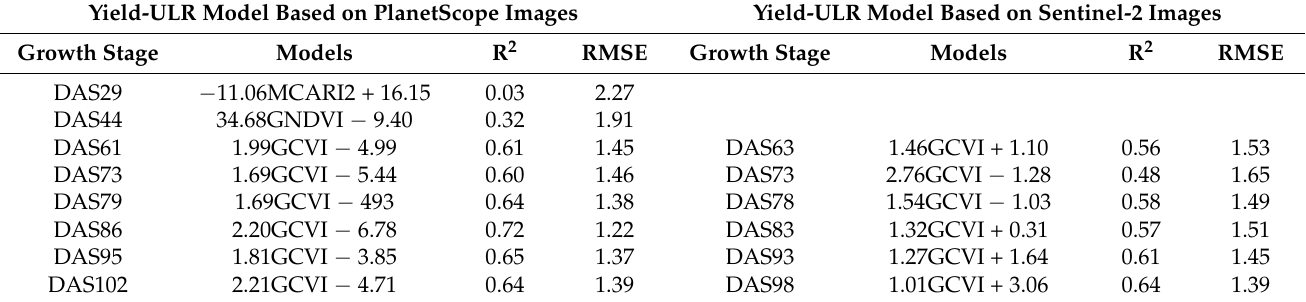
Table 3. The best Yield-ULR models constructed with PlanetScope and Sentinel-2 images. Yield-ULR Model Based on PlanetScope Images Yield-ULR Model Based on Sentinel-2